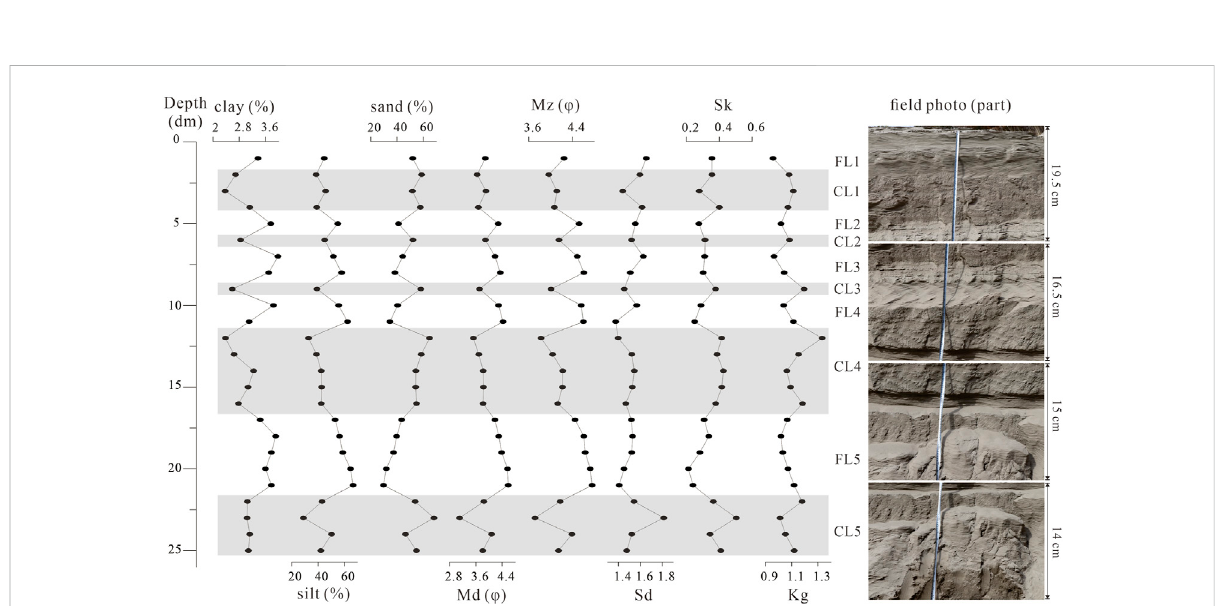
FIGURE 10 Verticalvariations ofdiluviagrainsizes fromtheanalytical resultsshown inFigure 5(Section3).The 250-cm depthsection canbeclassi fi edinto fi vecoarselayers(CL1 – CL5)and fi ve fi nelayers(FL1 – FL5),whichindicatethatthediluviumshowsgoodstrati fi cationandsortingcharacteristicsinthe dammed lake reaches of the canyon areas of large